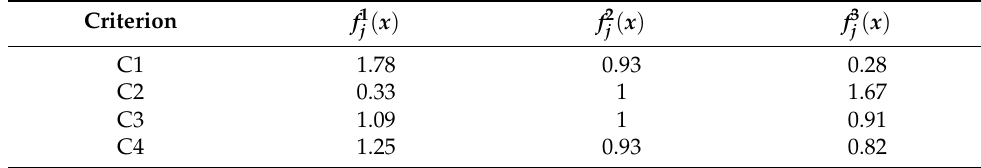
Table 6. Dimensionless values of the standard